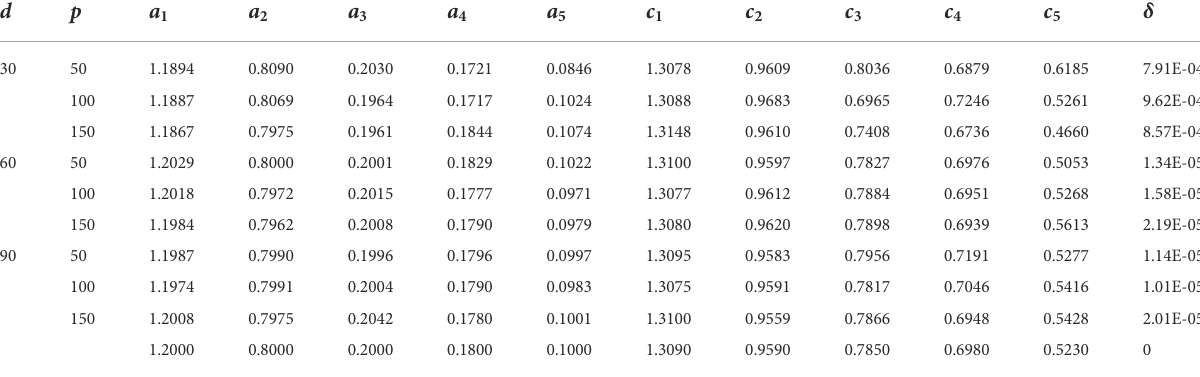
TABLE 5 Results of parameter estimates of Example 2 for G = 500.